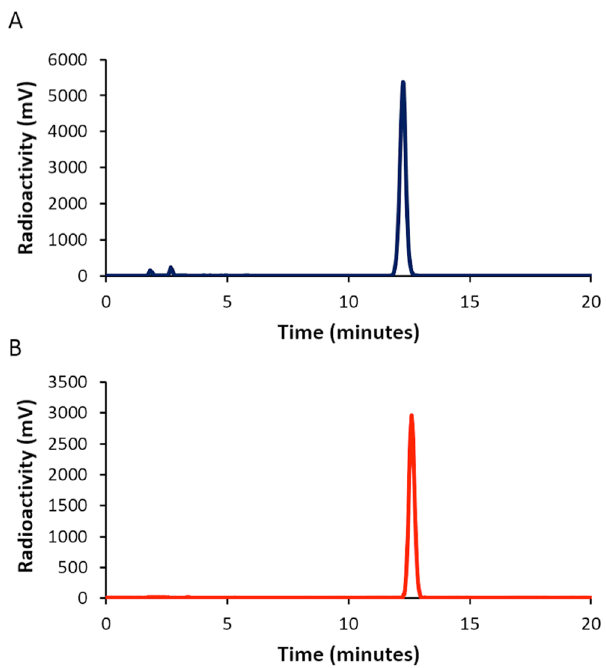
Figure 4. HPLC profiles of [ 125 I] 2 before ( A ) and after ( B ) incubation for 24